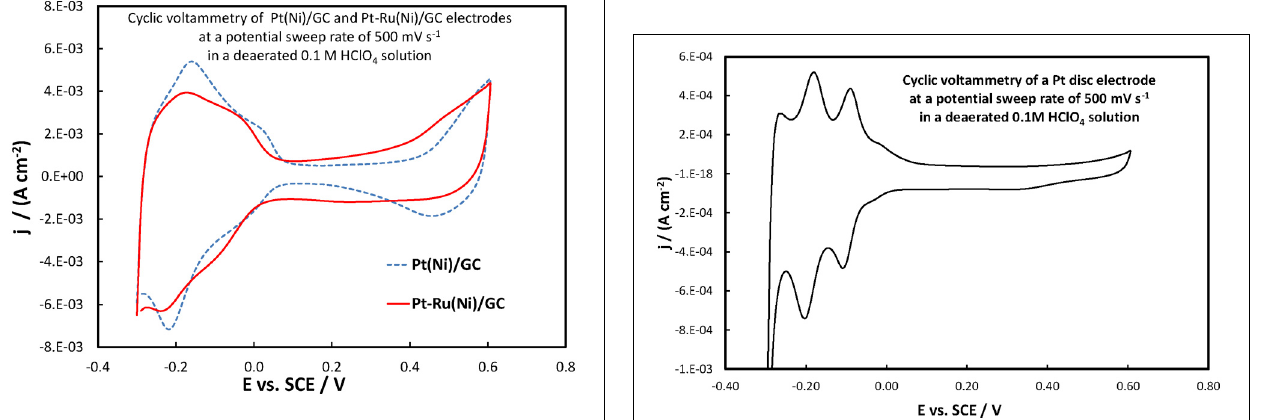
FIGURE 7 | Voltammogram of a Pt disc electrode in a deaerated 0.1M HClO 4 solution at 500mV s − 1 potential scan